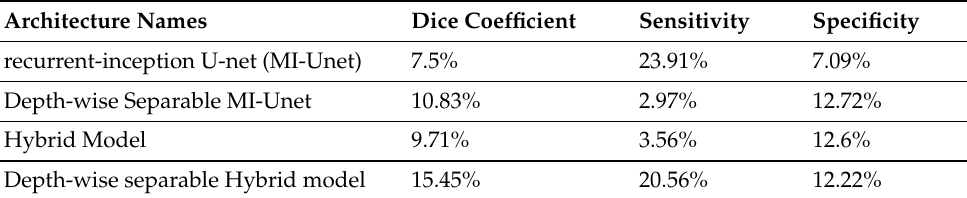
Table 3. Percentage Increase In Performance With Comparison to Baseline